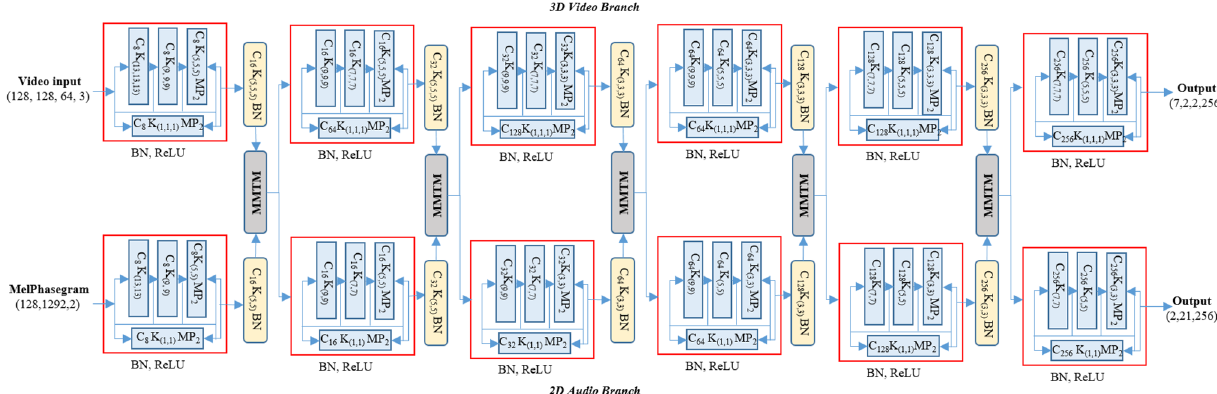
Figure 3. The music-video encoder network. Video stream (upper) and audio stream (lower) are connected with the MMTM information fusion